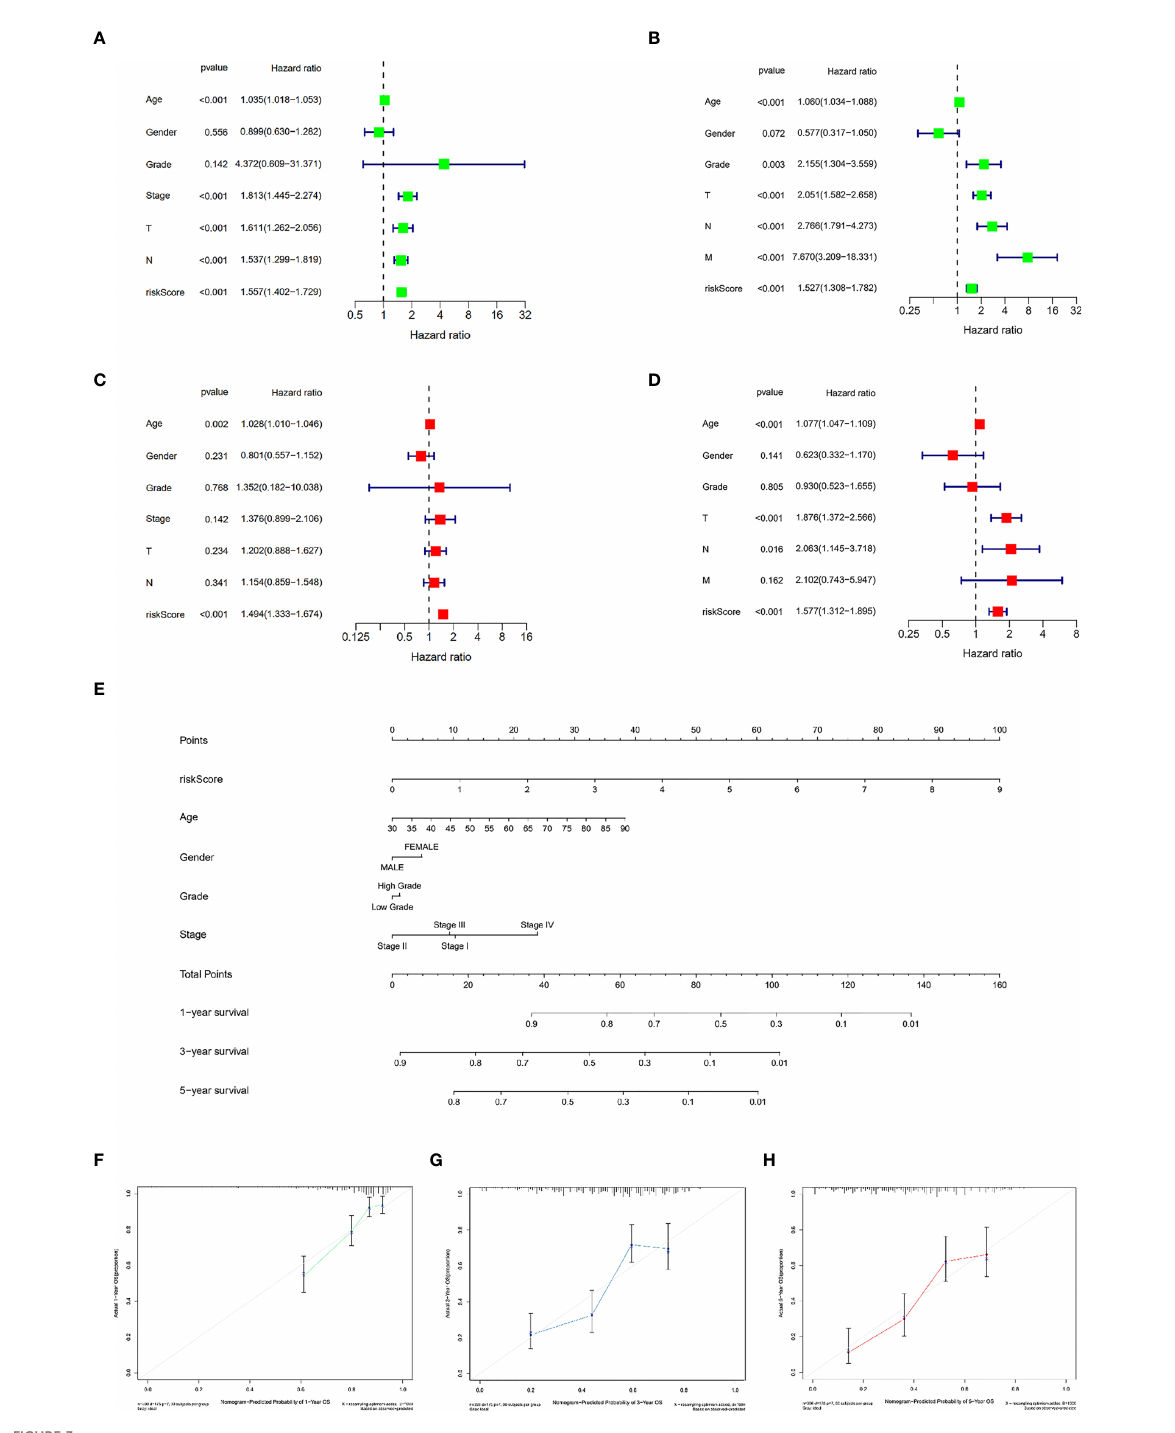
FIGURE 3 Establishment and assessment of the nomogram for survival prediction. Univariate and multivariate Cox regression analyses showed that risk score based on TILRGs is an independent prognostic factor affecting the prognosis of BCa patients in the TCGA-BLCA dataset (A, C) . Univariate and multivariate Cox regression analyses showed that risk score based on TILRGs is an independent prognostic factor affecting the prognosis of BCa patients in the GSE13507 dataset (B, D) . The nomogram combining risk score based on TILRGs and other clinicopathological parameters was developed to predict 1-, 3-, and 5-year survival (E) . Calibration curves showing the predictions of the nomogram that we established for 1- (F) , 3- (G) , and 5-year (H) overall